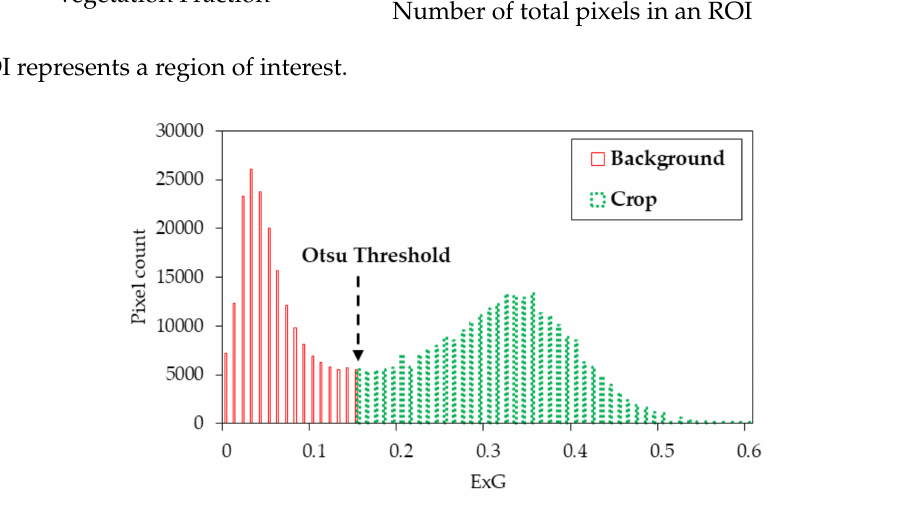
Figure 5. Excess green (ExG) histogram for vegetation classification with the Otsu threshold